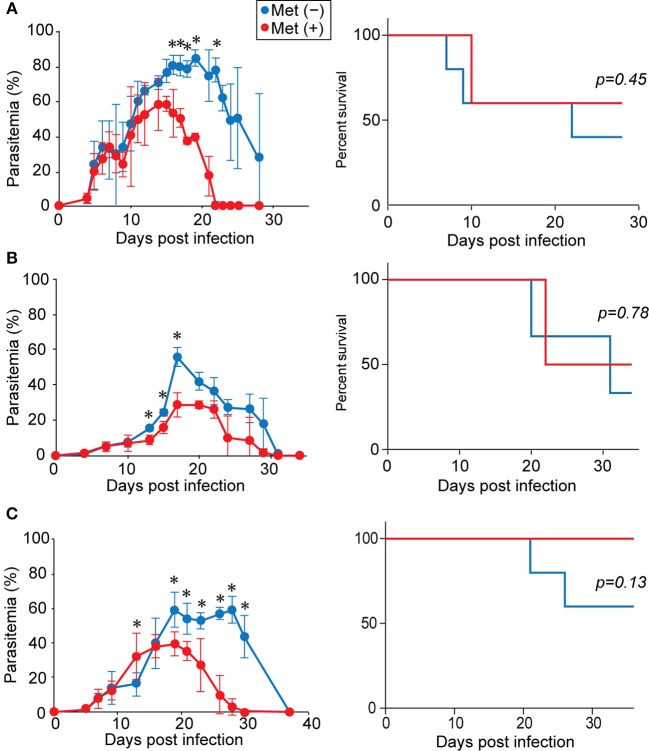
Metformin reduced parasitemia and promoted the clearance of Plasmodium parasites. B6 mice were infected with P. yoelii 17XL (A) or P. yoelii 17XNL (B) and received metformin (Met+, red line) or not (Met−, blue line) in their drinking water, starting from the day of infection. Alternatively, B6 mice were infected with P. yoelii 17XNL and either did (red line) or did not (blue line) receive metformin in their drinking water, starting at 7 d post-infection (C). The levels of parasitemia were monitored every few days. The data shown represent two (A), three (B), or one (C) experiment with 5 mice/group in each experiment. Statistical significance in the differences in parasitemia was assessed between the metformin-treated and untreated mice using the unpaired t-test with Welch's correction (*p < 0.05). Survival curves were compared using a log-rank (Mantel cox) test.